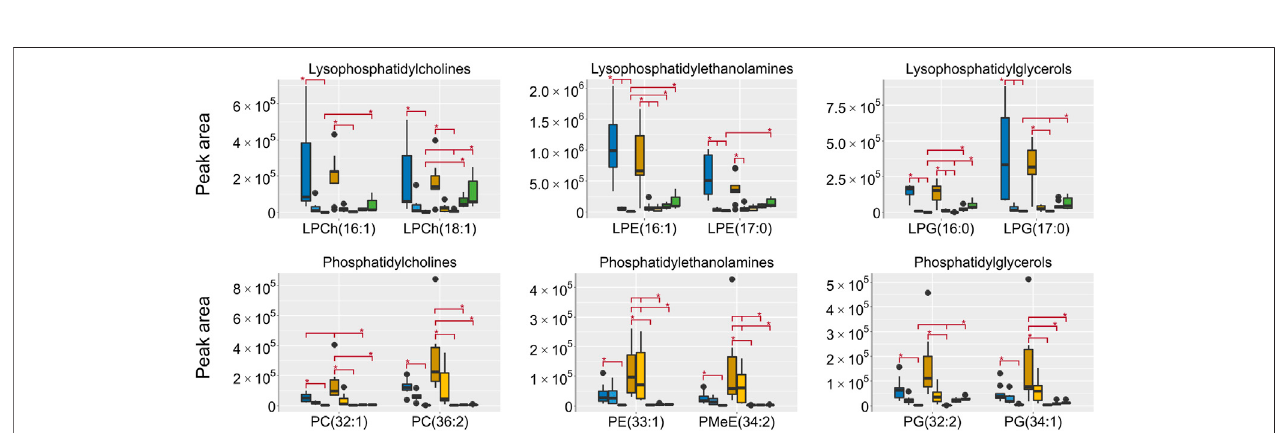
FIGURE 9 | Box plots of peak areas ( y -axis) of lipids found as differentiating between the sample groups in the aqueous extracts, the data was collected in HILIC negative ionization. Presented here are examples from each of the lipid classes, all annotated lipids can be found in the supplementary data. EtOH extr.1 (dark blue ), EtOHextr.2(blue ),EtOHsp.(lightblue ),MeOHextr.1(darkorange ),MeOHextr.2(yellow ),MeOHsp.(lightyellow ),frozen(darkgreen ),and fl ashfrozen (green ). Outliers aredenoted as dots in theplots. Statistical signi fi cance ( p < 0.05) ismarked by* in the respective box-plots, all p -values from the Kruskal Wallis and Nemenyi post-hoc testing can be found in supplementary data, Supplementary Table S12